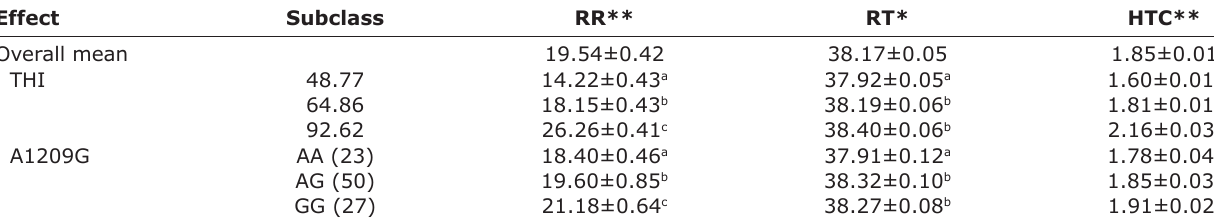
Table-3: Least squares means of subclasses of different fixed effects for RR, RT, and HTC in Sahiwal cows.